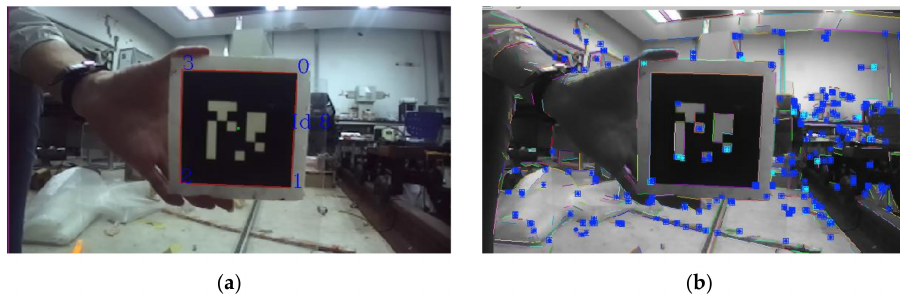
Figure 6. Comparison of pose measurement experiments with the AR-marker. ( a ) The red square locking AR-marker indicated that the recognition of the AR-marker was successful, which allows us to obtain the transformation matrix between the camera coordinate system and the AR-marker coordinate system. ( b ) Using the AR-marker recognition program and PL-SLAM simultaneously.